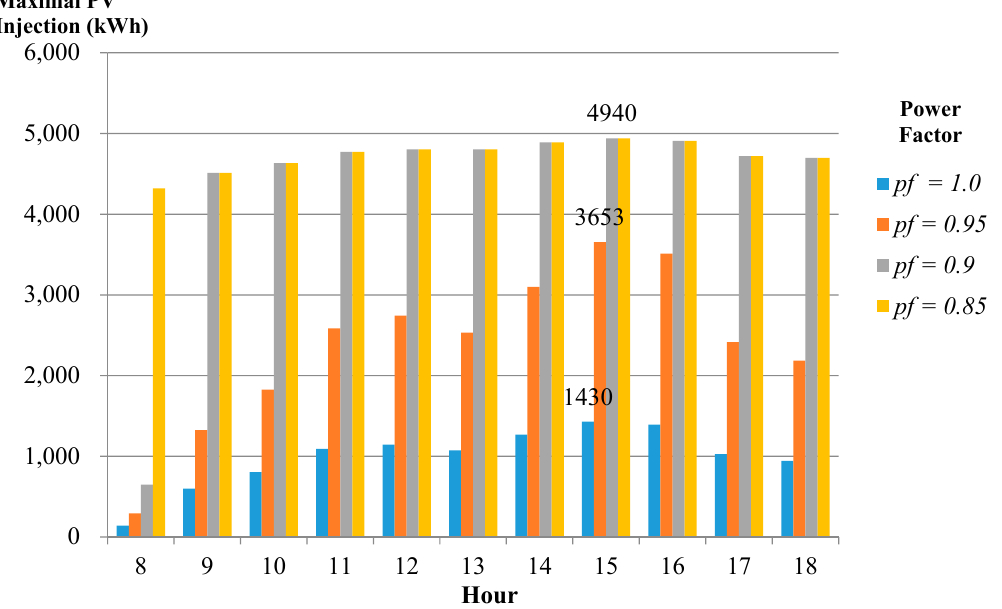
Figure 6. Maximal PV real power injection for control abilities pf = 1.0, 0.95, 0.9, and 0.85.